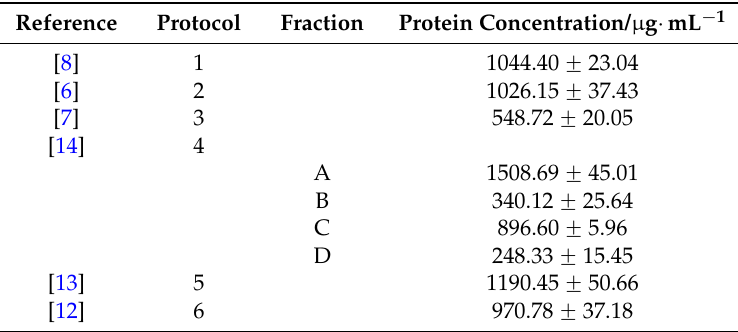
Table 1. Total protein concentration measured by the Bradford method using bovine serum albumin (BSA) as